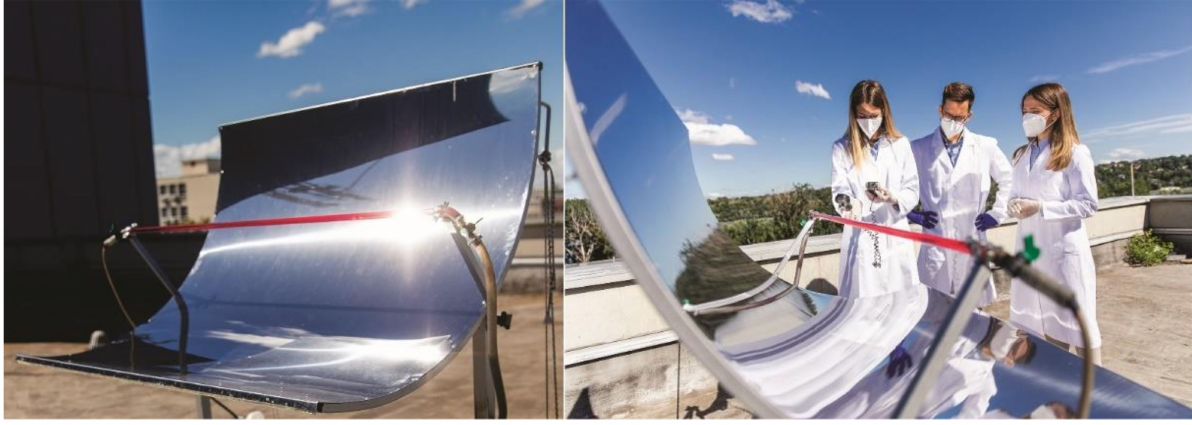
Figure 12. Parabolic trough concentrating